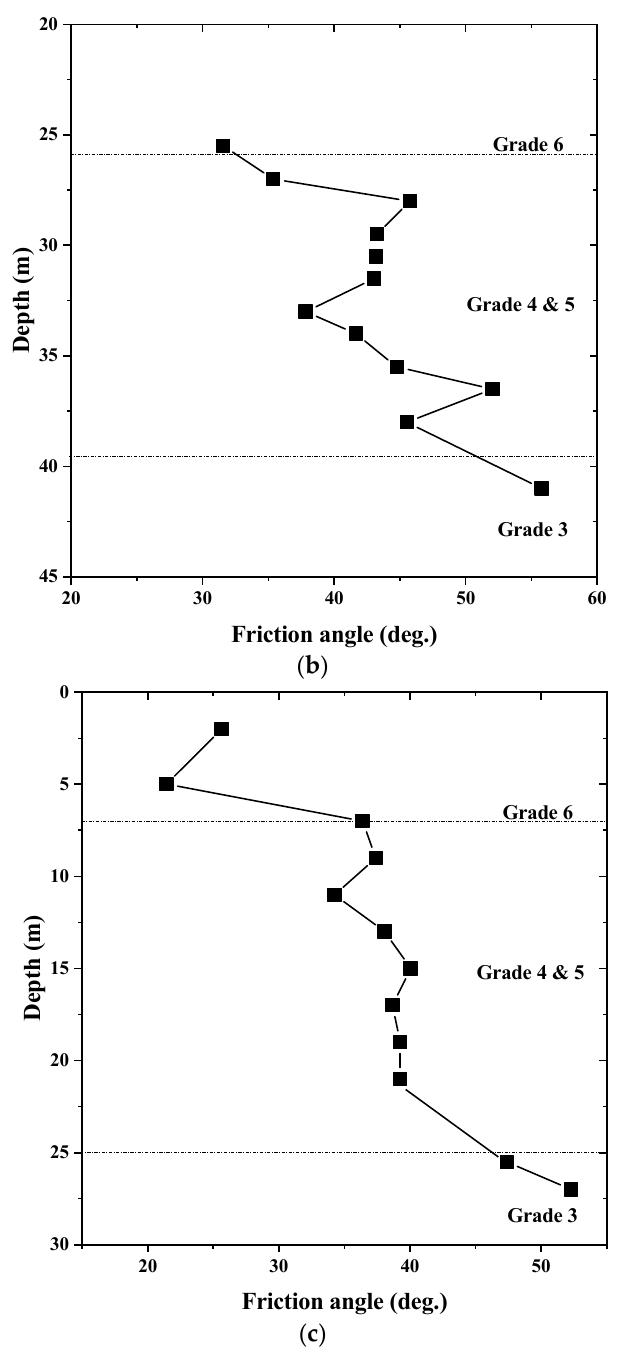
Figure 5. Distribution of friction angles: ( a ) A site; ( b ) G site; ( c ) S site.